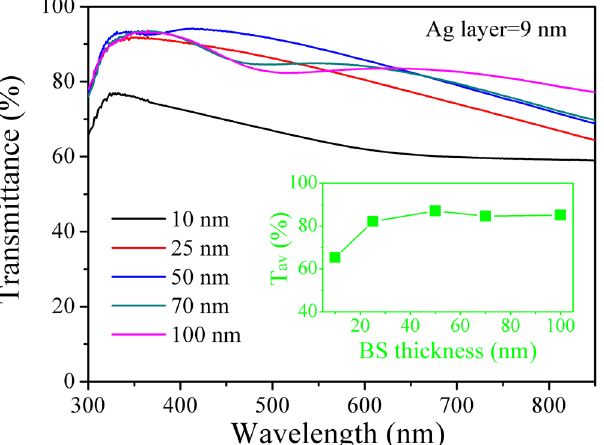
Figure 5. Transmittance spectra of BS/Ag (9 nm)/BS multilayer flexible thin films with various thicknesses of BS layers. Inset is the average optical transmittance in the visible range (380 nm~780 nm) of the multilayer flexible thin films as a function of BS layers thickness.